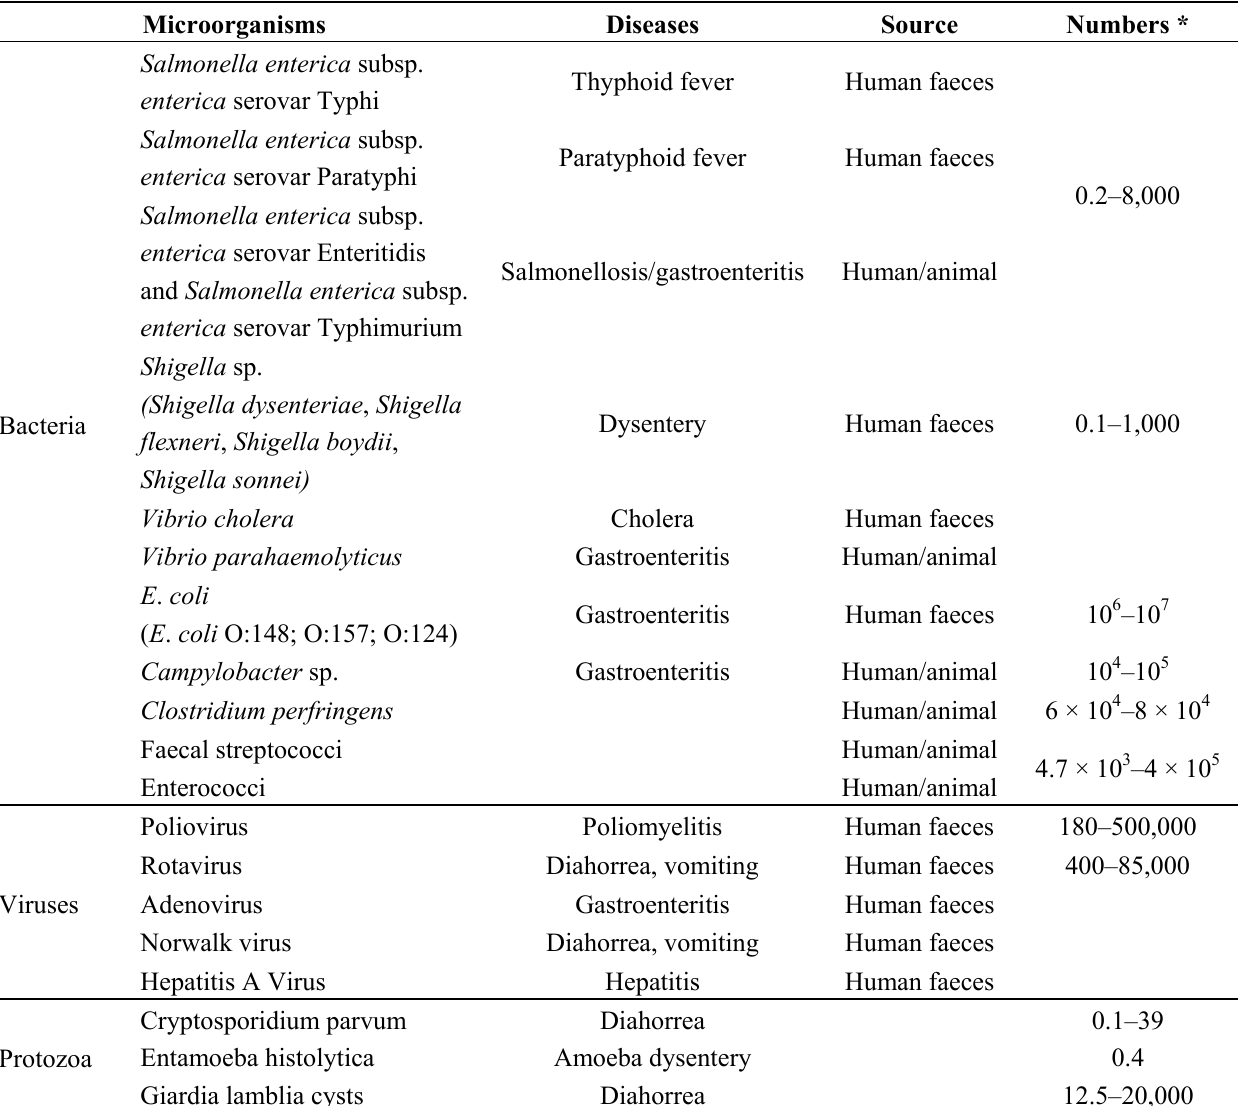
Table 3. Microbial indicators and pathogenic organisms associated with waterborne diseases and common sources of